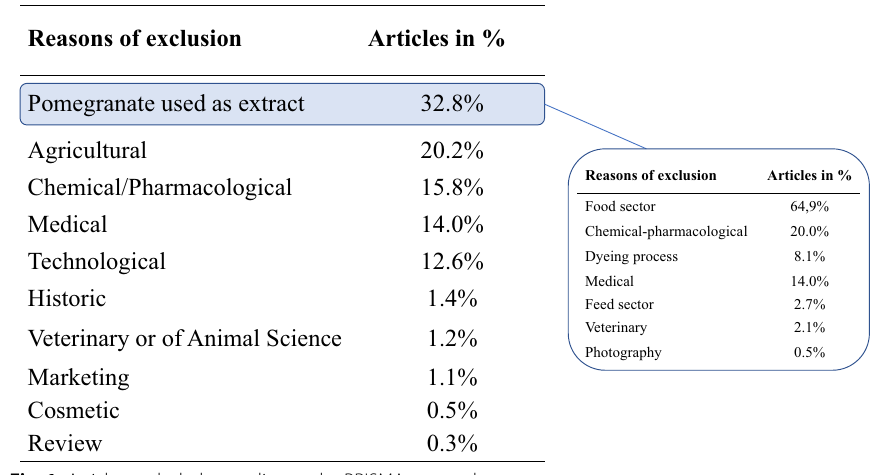
Fig. 1 Articles excluded according to the PRISMA